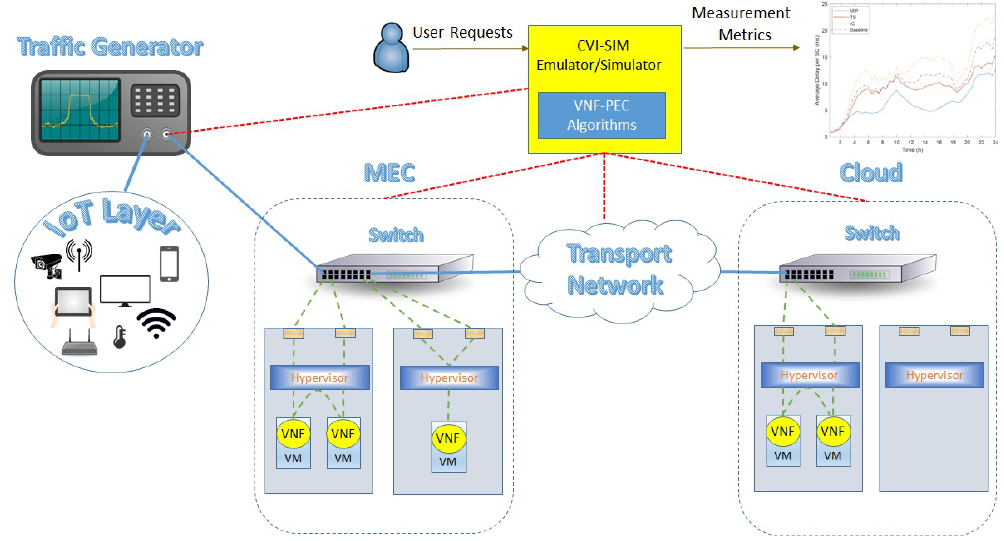
Figure 15. Hybrid simulation/emulation